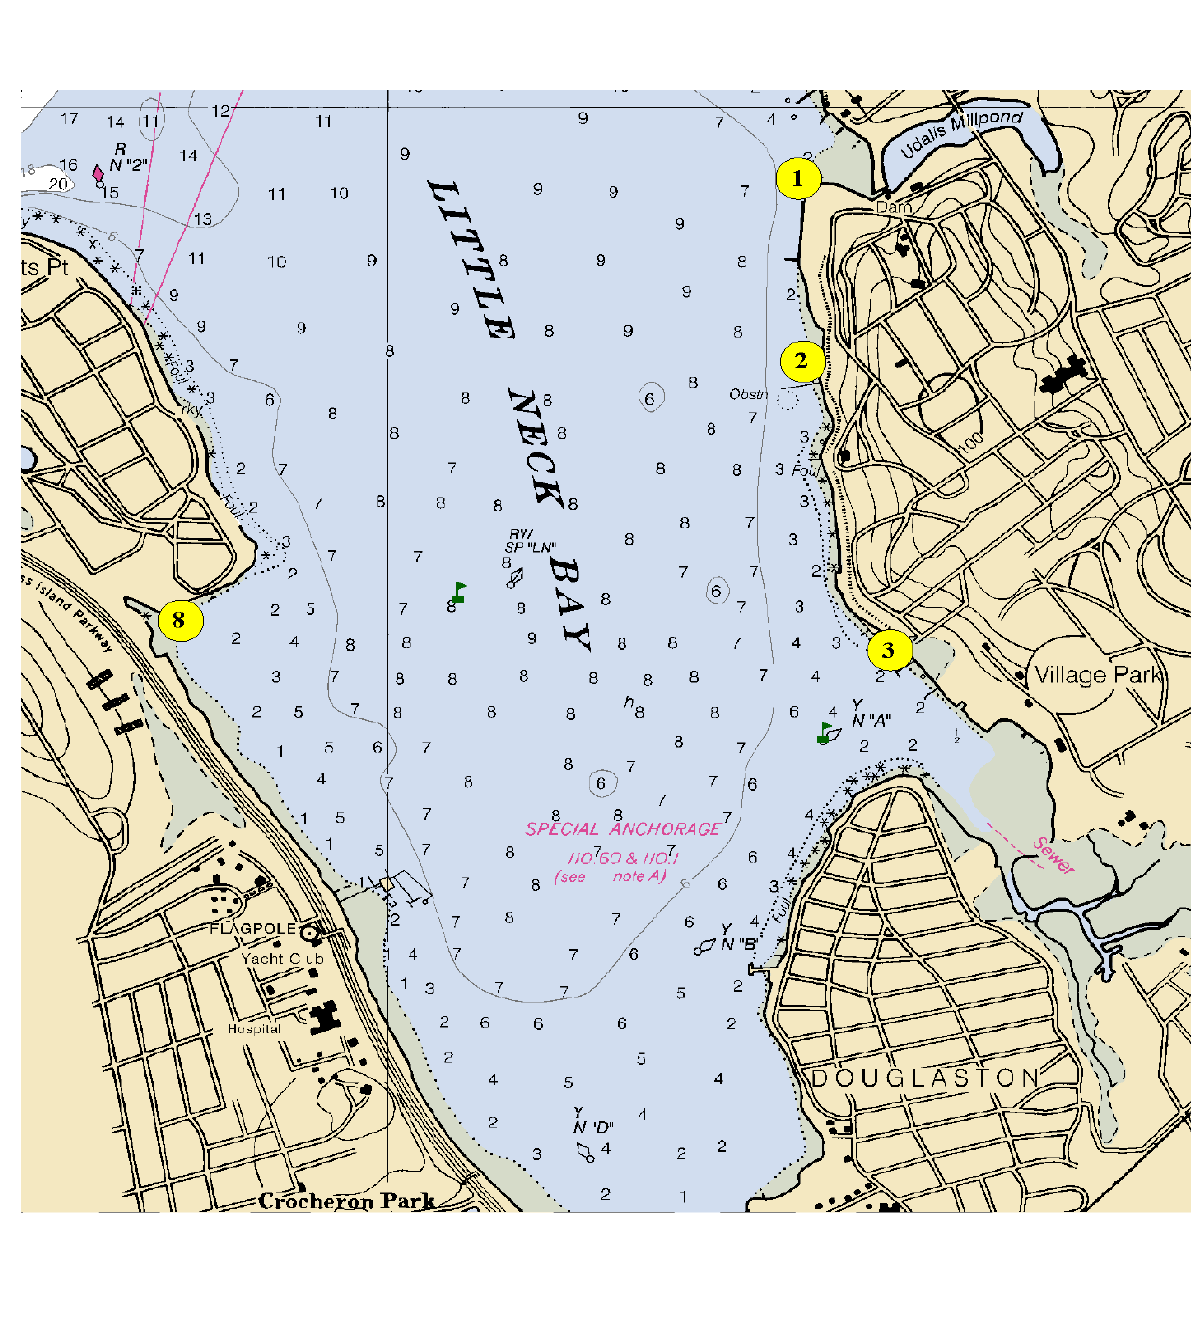
Figure 36. Map of New York DEC Western Long Island Beach Seine Survey Little Neck Bay